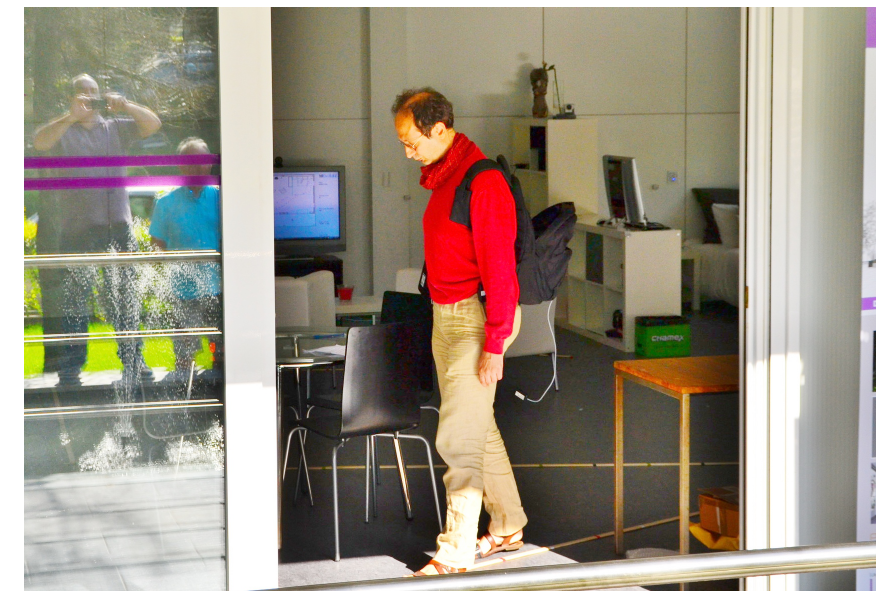
Figure 9. Actor moving on a path during a